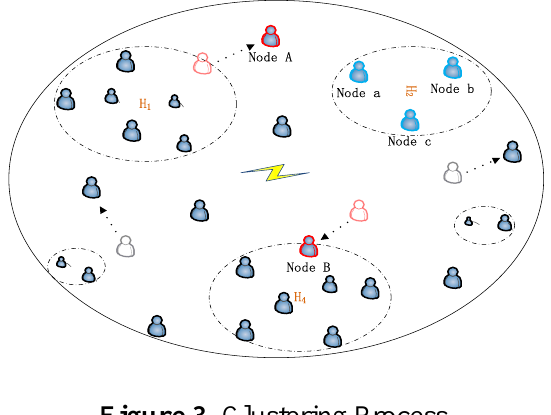
Figure 3. Clustering Process.